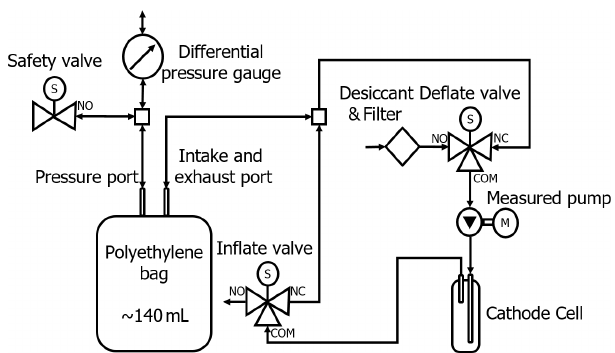
Figure 6. Airbag-type flowmeter piping connection. The 140mL bag is made of polyethylene. The inflation and deflation of the bag are conducted by using two magnet valves. The pressure between the inside and outside of the bag is measured with a differential pressure gauge. Temperatures in the bag and pump are measured by thermometers. The revolving speed of the pump is measured by an optical